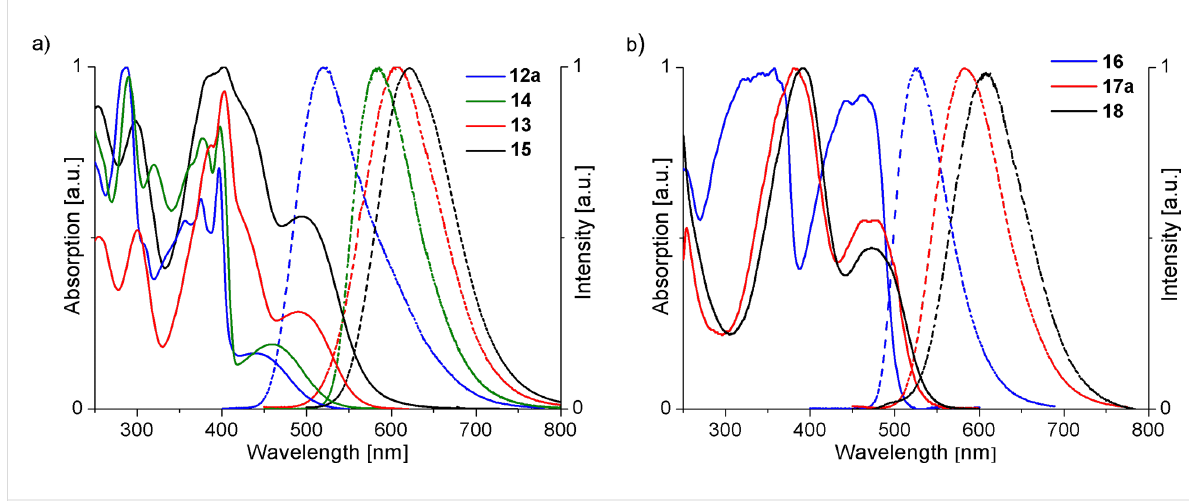
Figure 1: a) Absorption (solid lines) and emission (dotted lines) spectra of compounds 12a (blue), 13 (red), 14 (green) and 15 (black) in solution (CH 2 Cl 2 ). b) Absorption (solid lines) and emission (dotted lines) spectra of compounds 16 (blue), 17a (red), 18 (black) in solution (CH 2 Cl 2 ).